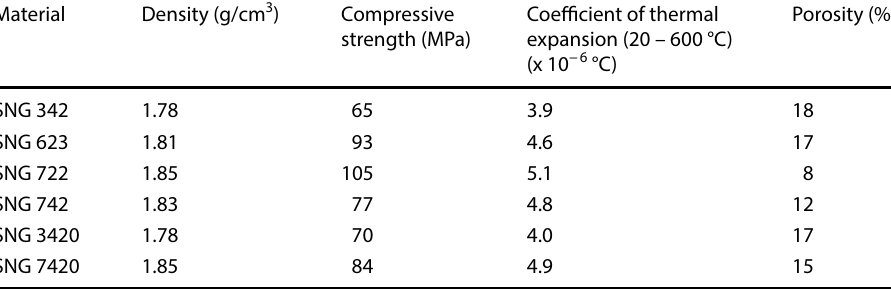
Table 1 Nominal properties of the synthetic graphite produced by Sinosteel Advanced Materials (China) and supplied to the authors for the experimental programme presented in this paper. Information is provided for all the grades